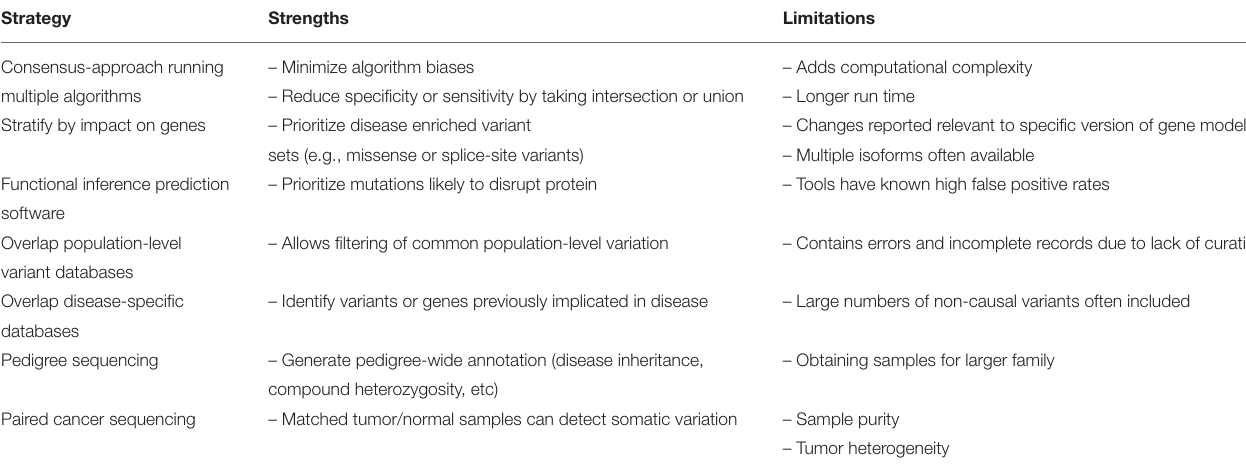
TABLE 4 | Strategies for variant